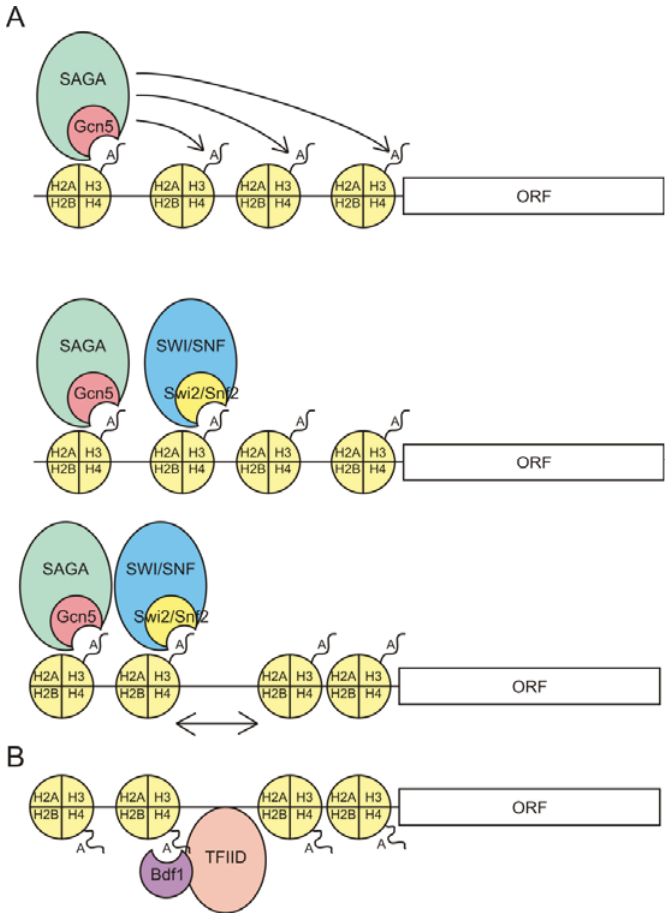
Figure 1. Examples of mechanisms by which bromodomain proteins regulate gene expression in budding yeast. ( a ) The bromodomain of Gcn5 binds to acetylated H3